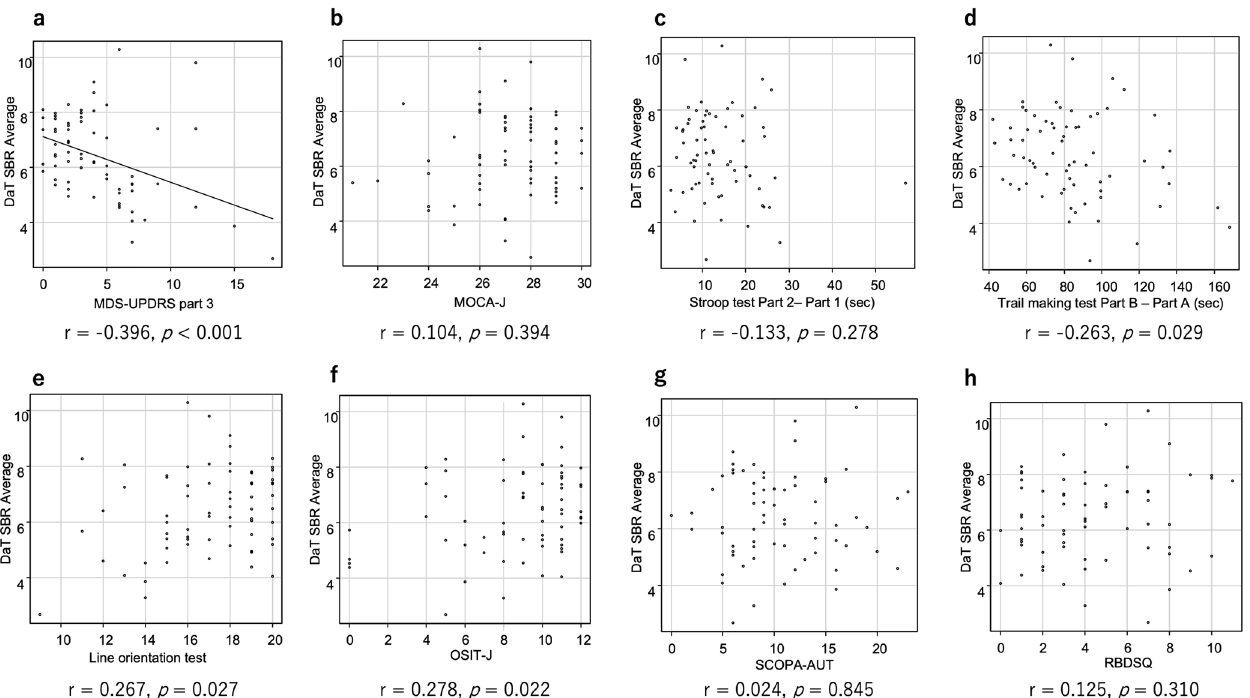
Fig. 3 The correlation between DaT-SPECT SBR and clinical indices in the high-risk subjects. Pearson ’ s correlation test comparing the DaT SBR and motor ( a ) and cognitive ( b – e ) functions as well as non-motor symptoms ( f – h ) in the participants. DaT dopamine transporter, SBR speci fi c binding ratio, MDS-UPDRS Movement Disorder Society-sponsored revision of the Uni fi ed Parkinson ’ s Disease Rating Scale, MoCA-J the Japanese version of the Montreal Cognitive Assessment, OSIT-J the odor stick identi fi cation test for Japanese, SCOPA-AUT the Japanese version of the Scale for Outcomes in Parkinson ’ s disease for Autonomic Symptoms, RBDSQ RBD screening